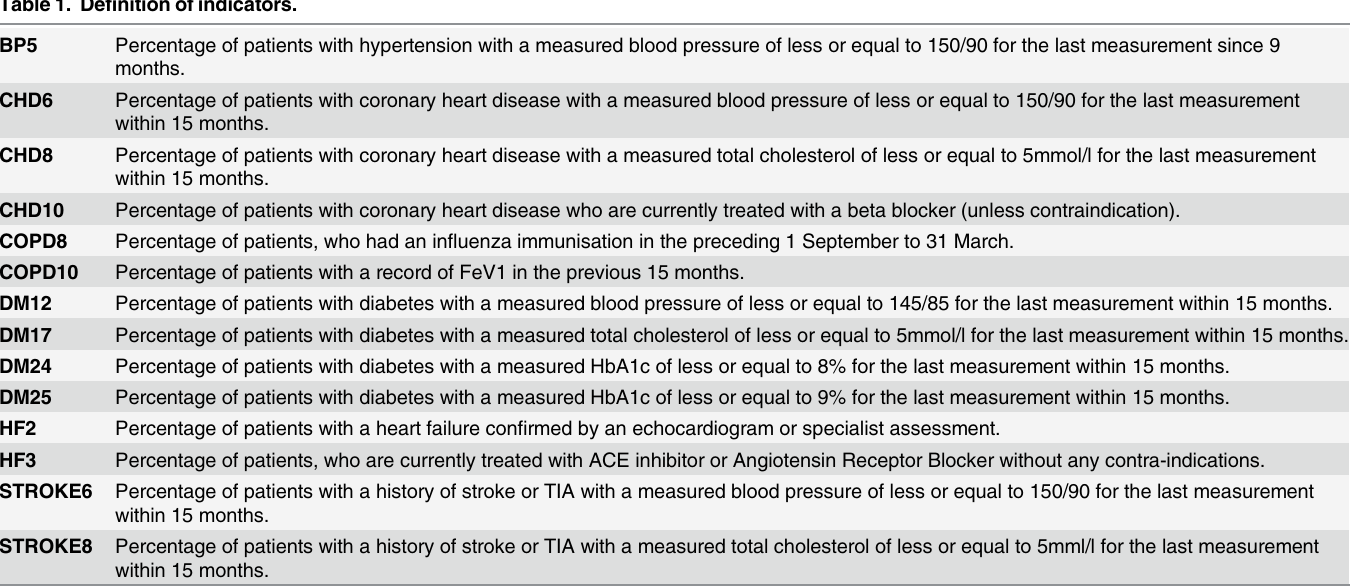
Table 1. Definition of indicators. BP5 Percentage of patients with hypertension with a measured blood pressure of less or equal to 150/90 for the last measurement since 9 months. CHD6 Percentage of patients with coronary heart disease with a measured blood pressure of less or equal to 150/90 for the last measurement within 15 months. CHD8 Percentage of patients with coronary heart disease with a measured total cholesterol of less or equal to 5mmol/l for the last measurement within 15 months. CHD10 Percentage of patients with coronary heart disease who are currently treated with a beta blocker (unless contraindication). COPD8 Percentage of patients, who had an in fl uenza immunisation in the preceding 1 September to 31 March. COPD10 Percentage of patients with a record of FeV1 in the previous 15 months. DM12 Percentage of patients with diabetes with a measured blood pressure of less or equal to 145/85 for the last measurement within 15 months. DM17 Percentage of patients with diabetes with a measured total cholesterol of less or equal to 5mmol/l for the last measurement within 15 months. DM24 Percentage of patients with diabetes with a measured HbA1c of less or equal to 8% for the last measurement within 15 months. DM25 Percentage of patients with diabetes with a measured HbA1c of less or equal to 9% for the last measurement within 15 months. HF2 Percentage of patients with a heart failure con fi rmed by an echocardiogram or specialist assessment. HF3 Percentage of patients, who are currently treated with ACE inhibitor or Angiotensin Receptor Blocker without any contra-indications. STROKE6 Percentage of patients with a history of stroke or TIA with a measured blood pressure of less or equal to 150/90 for the last measurement within 15 months. STROKE8 Percentage of patients with a history of stroke or TIA with a measured total cholesterol of less or equal to 5mml/l for the last measurement within 15 months.